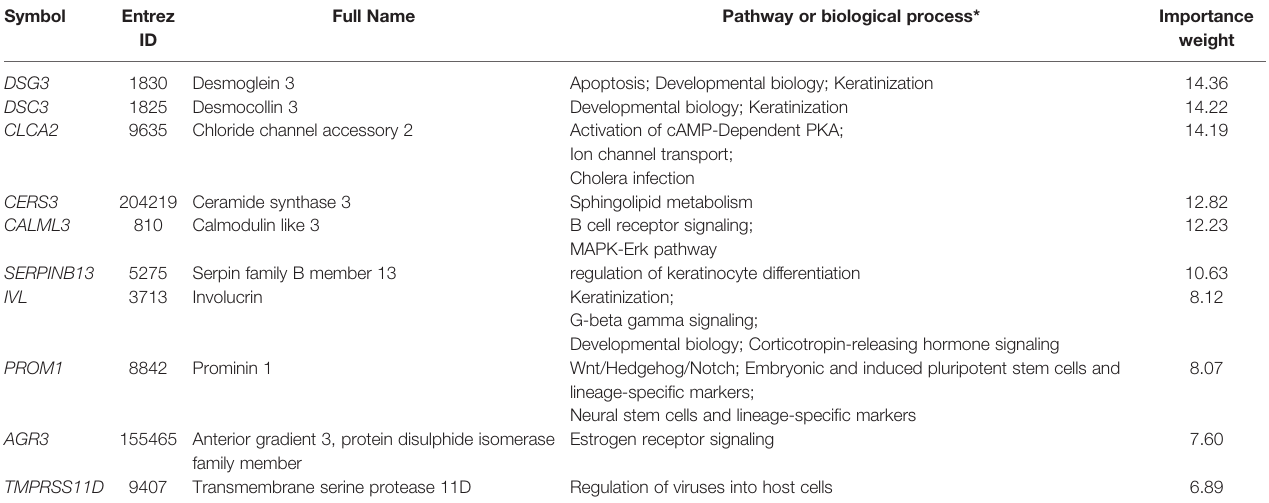
TABLE 2 | The 10 genes with the highest importance weights in the prediction model.